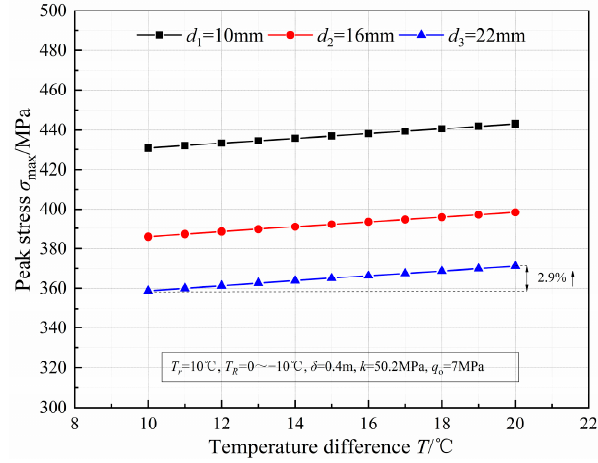
Figure 5. Pipe stress peak caused by temperature differences under various pipe wall thicknesses.